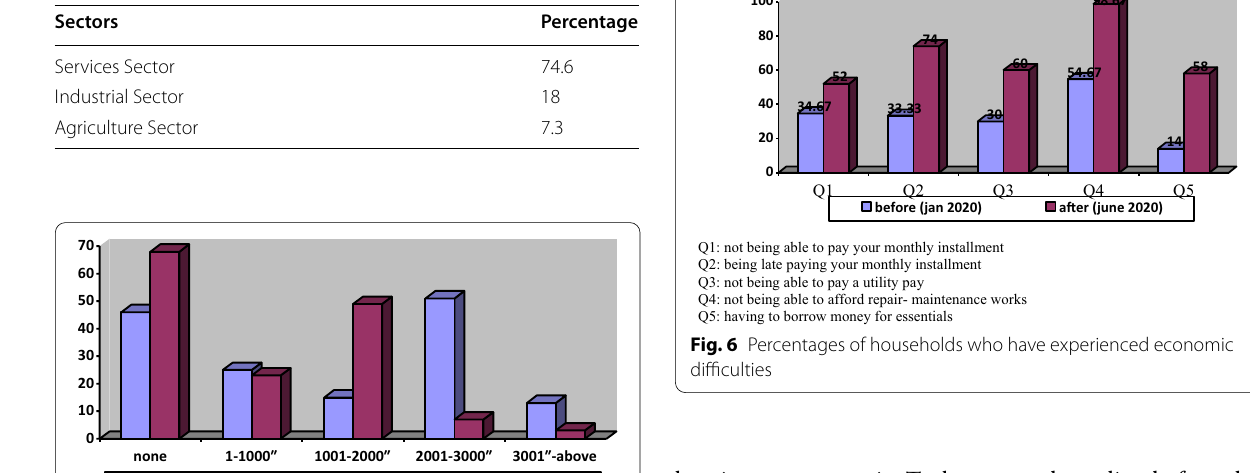
Table 1 Distribution by sectors worked